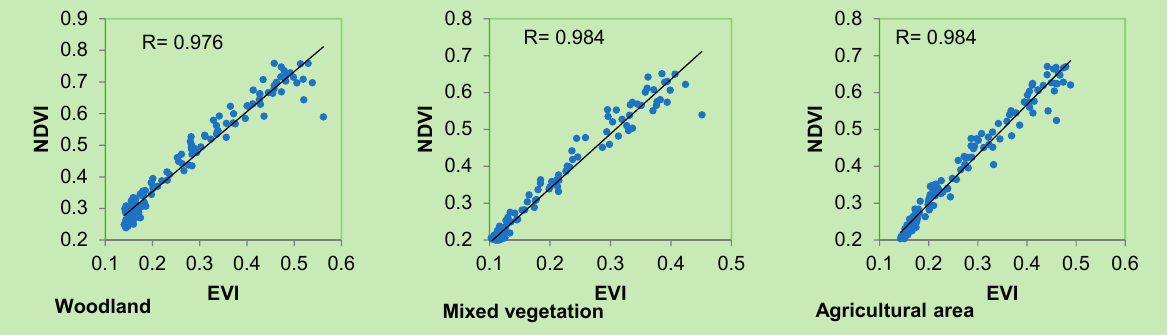
Figure 5. Correlation between NDVI and EVI for different land use/cover